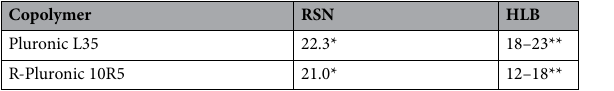
Table 1. As they have reported the studied block copolymers are similar in hydrophilicity and molecular weight leading to little difference in their binodal curve. Several tie-lines were determined for each system at 298 K. The equilibrium concentrations, TLL and STL are reported in table S3-S5. The changes in STL are due to the difference hydrophobicity of the copolymers. In the ATPSs of Pluronic L35, R-Pluronic 10R5 and UCON the absolute value of STL follows: Pluronic L35 ≈ R-Pluronic 10R5 > UCON.